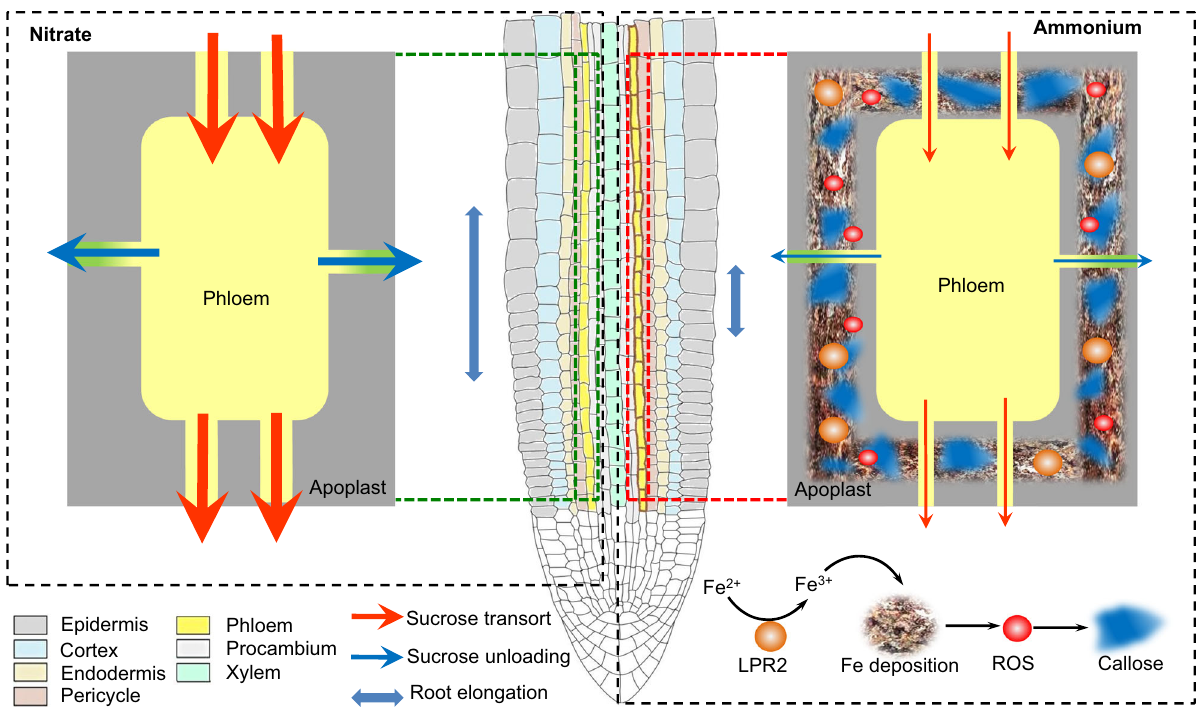
Fig. 8 Schematic model of the mechanism that connects remodeling of root development to NH4 + as the primary N source. In comparison with NO 3 − as the primary N source, NH 4 + supplementation as the predominant N source induces excessive Fe deposits in the apoplast of root phloem via a catalytic reaction of Fe 2 + oxidation to Fe 3 + , which depends on the action of the cell wall-localized ferroxidase LPR2 in root stele. Such an aberrant Fe accumulation then inhibits phloem transport and unloading by triggering a burst of reactive oxygen species, which subsequently induces massive callose deposition. Consequently, sucrose is insuf fi ciently allocated to the root growth zone, which arrests root